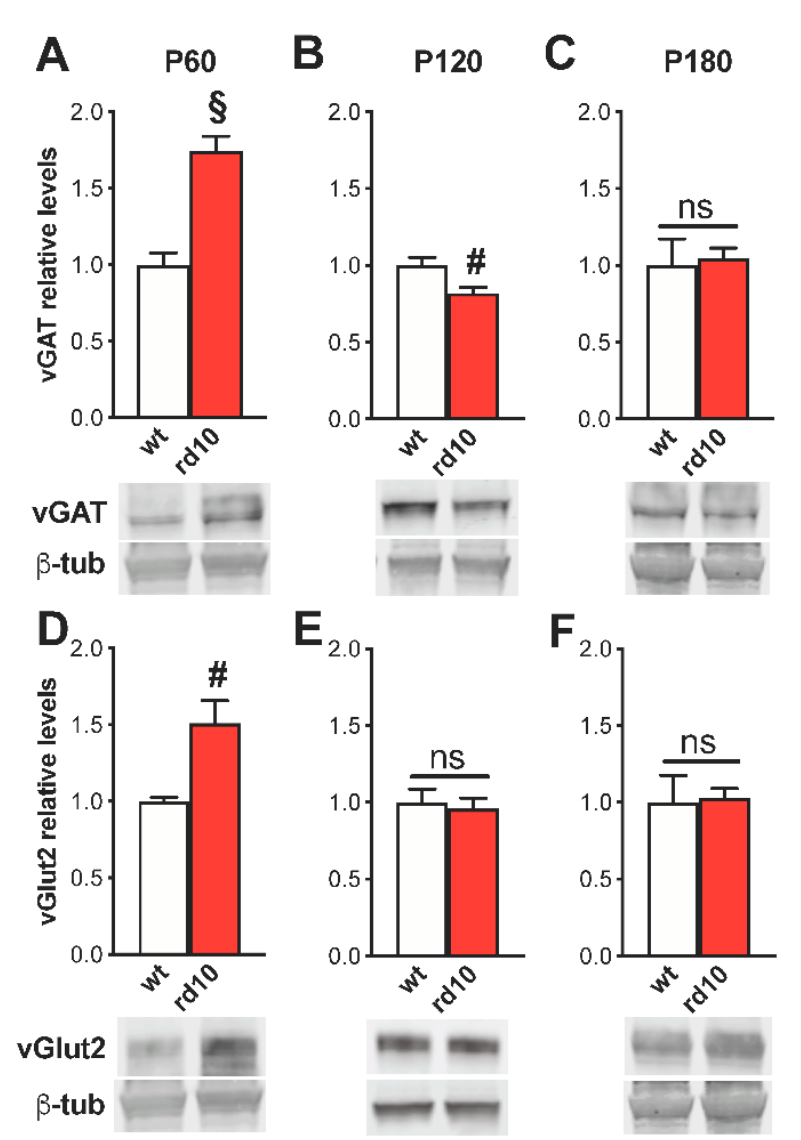
Figure 1. Age-dependent alterations of vGAT and vGlut2 levels in the visual cortex of rd10 animals. In all panels, the inset is a representative immunoblotting showing the corresponding protein levels in the visual cortex of wild-type (wt) and rd10 transgenic animals. β -Tubulin ( β -tub) is the internal standard. Diagrams show the percentage value of protein expression in relation to the control (wt) group. ( A – D ) At P60, protein levels of vGAT and vGlut2 were almost two-fold increased in the visual cortex of rd10 mice ( n = 8) compared to age-matched wt mice ( n = 8; t -test, p < 0.001 and Mann–Whitney rank sum test, p < 0.01). ( B – E ) A significant reduction of vGAT protein expression in rd10 mice ( n = 8) with respect to wt animals ( n = 8; t -test, p < 0.01) was present at P120. We did not find a parallel alteration of vGlut2 ( t -test, p = 0.705). ( C – F ) At P180, the differences between the two groups were lost (rd10 n = 8, wt n = 4; t -test, vGAT p = 0.764 and vGlut2 p = 0.863). Data are expressed as mean ± s.e.m. # p < 0.01, § p < 0.001, and ns: not